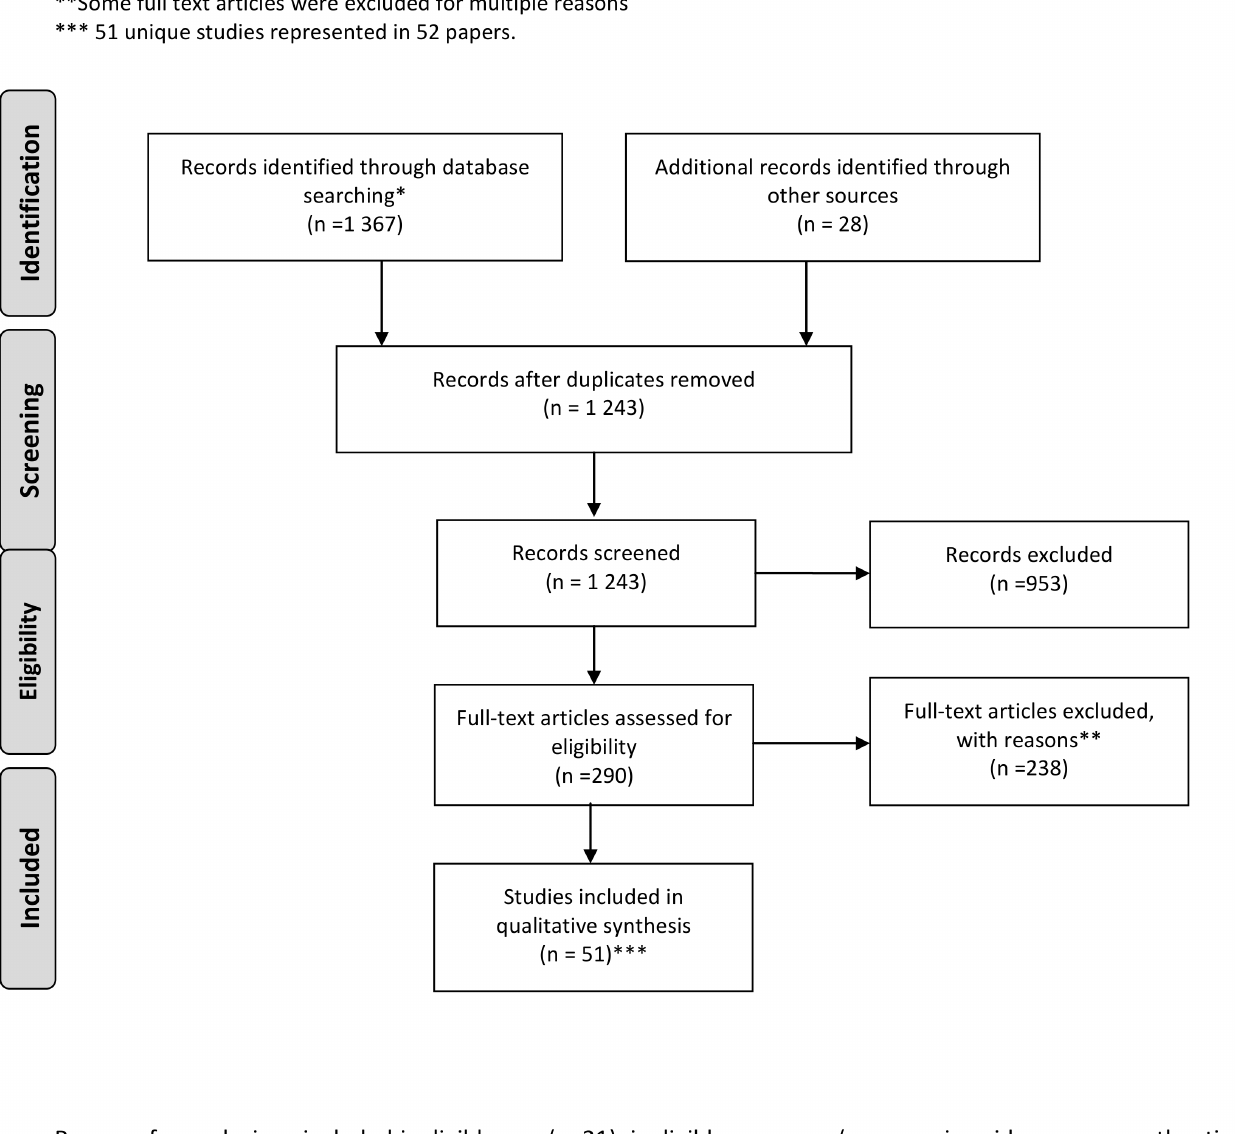
Figure 1. Prisma flow diagram of included studies. doi:10.1371/journal.pone.0065351.g001 MVPA during fitness class and playing football, than when playing DDR.